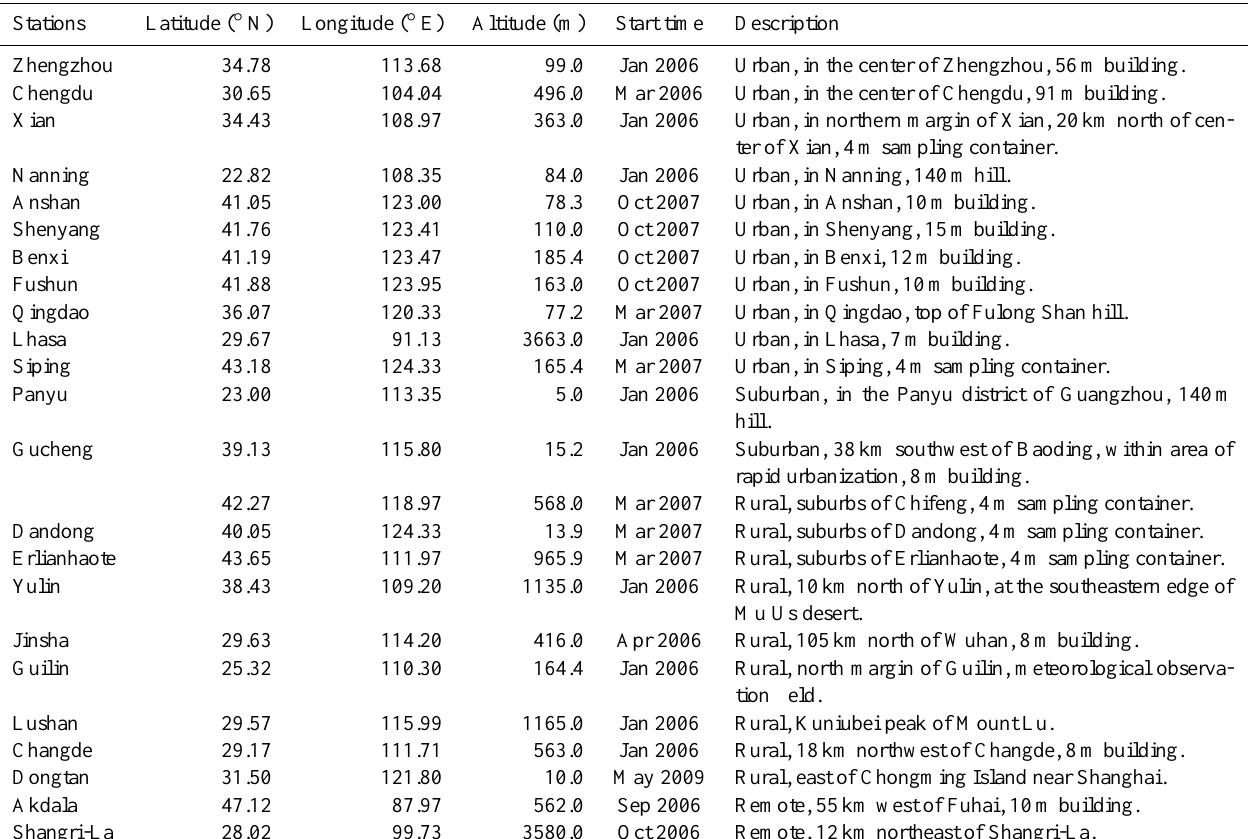
Table 1. Description of the PM stations.